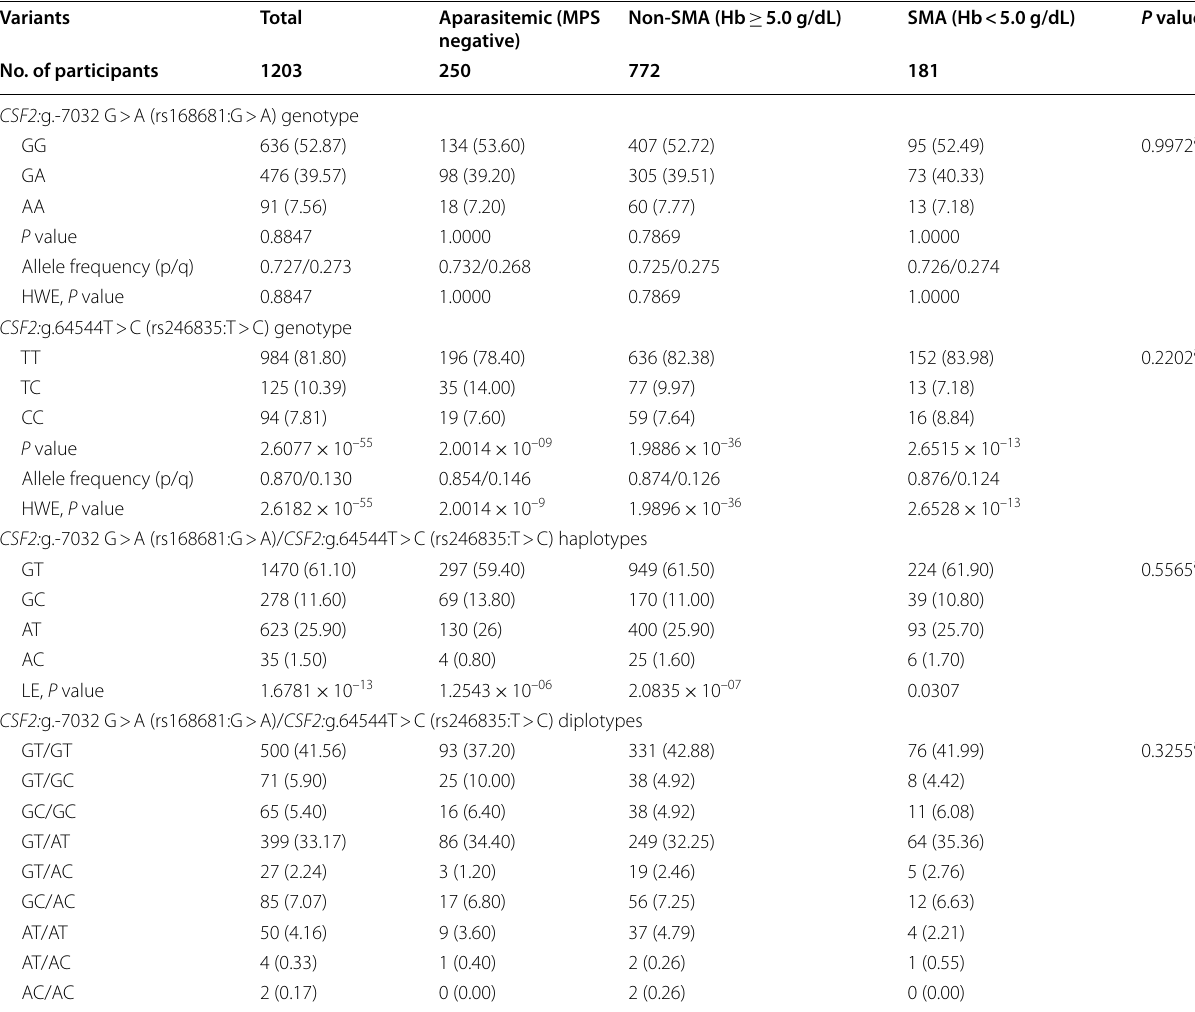
Table 2 Distribution of CSF2 genotypes, haplotypes, and